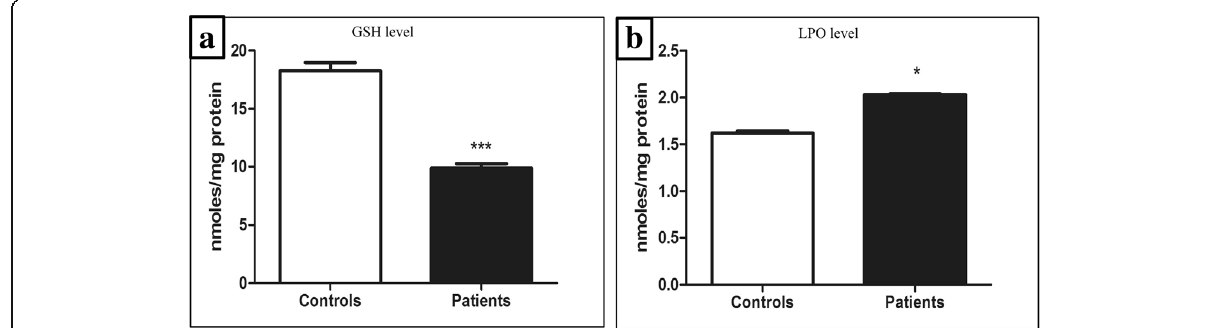
Fig. 5 Statistical analysis of the amount of ( a ) reduced glutathione ( b ) lipid peroxidation in plasma samples of controls and patients. All values are calculated as Mean ± SD. * p < 0.05; *** p <